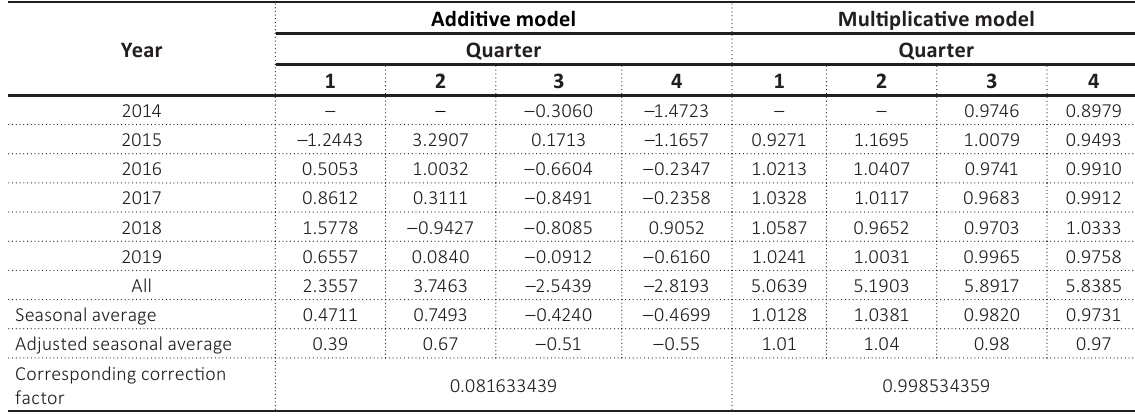
Table B1. Estimation of the seasonal component of the additive and multiplicative models Additive model